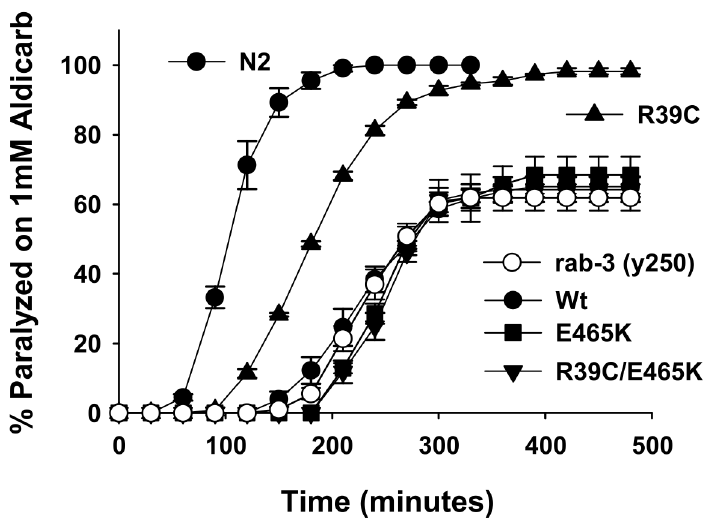
Figure 5. The R39C unc-18 point mutation suppresses the rab-3 -dependent resistance to aldicarb. Loss-of-function ( lof ) rab-3 ( y250 ) worms were created to express transgenically wild-type (Wt) unc-18 or unc-18 with the indicated mutations. In comparison to Bristol N2 worms, lof rab-3 worms exhibited resistance to aldicarb. This resistance to aldicarb was blocked partially by expression of R39C unc-18 . The R39C/E465K double mutation did not affect rab-3 aldicarb sensitivity. Significance was assessed by two-way analysis of variance with post-hoc comparisons. Only worms expressing R39C (P<0.001) had altered aldicarb sensitivity in comparison to rab-3 worms. N = 3 experiments per strain (20-25 worms each experiment). doi: